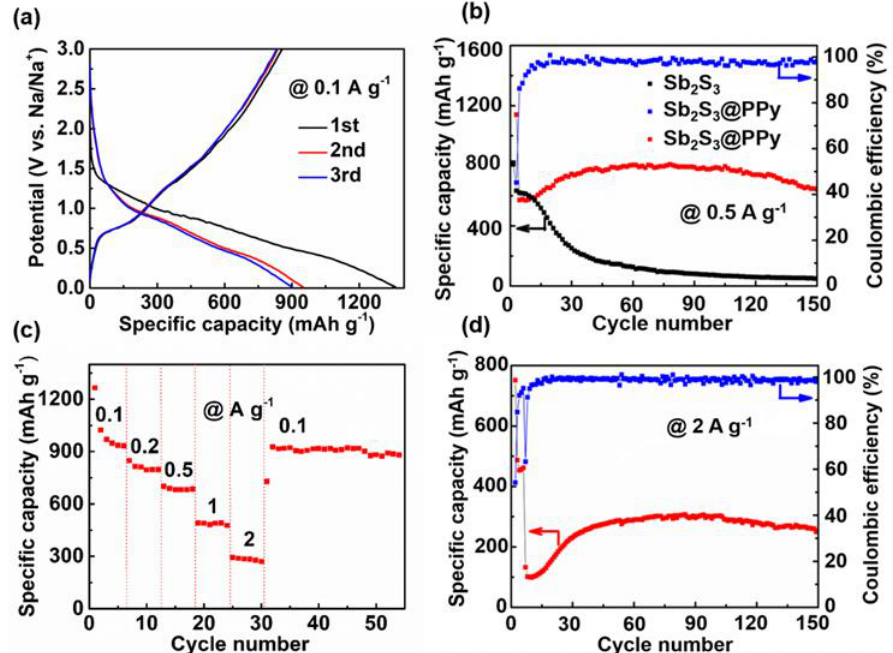
Figure 3. Electrochemical performances of Sb 2 S 3 @PPy or Sb 2 S 3 as an anode in sodium ion batteries (SIBs). ( a ) Galvanostatic charge and discharge curves of Sb 2 S 3 @PPy at 0.1 A g − 1 for the first three cycles. ( b ) Cycling stability of Sb 2 S 3 @PPy and Sb 2 S 3 at 0.5 A g − 1 , and corresponding Coulombic efficiency of Sb 2 S 3 @PPy at 0.5 A g − 1 . ( c ) Rate capability of Sb 2 S 3 @PPy from 0.1 to 2 A g − 1 . ( d ) Cycling stability and